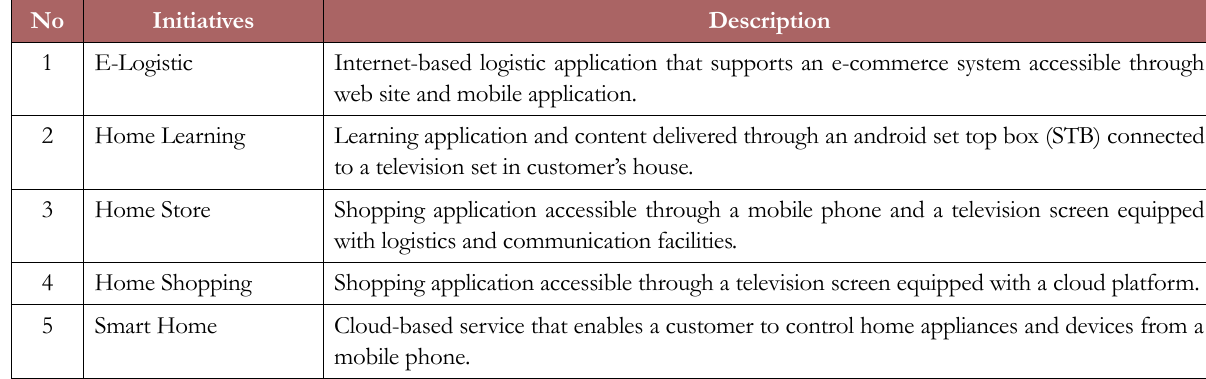
Table 4. Description of Selected OTT